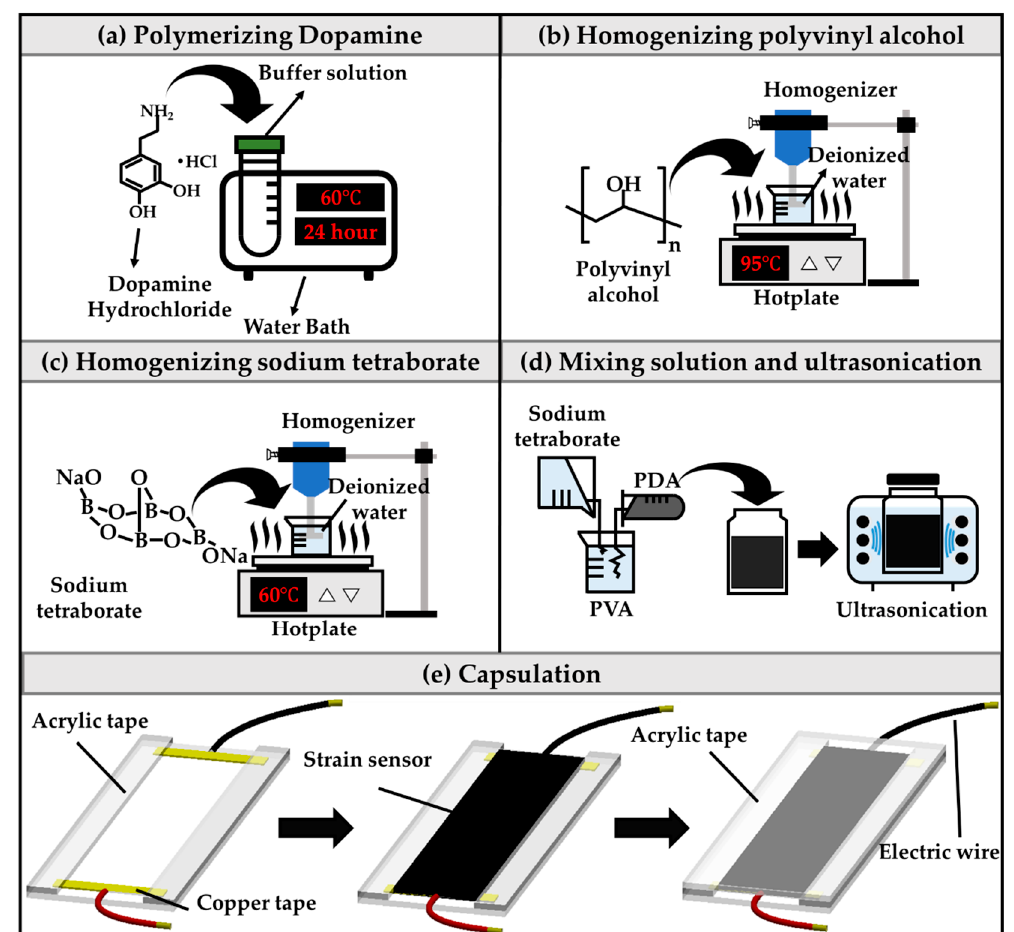
Figure 4. Complete process of sensor fabrication. (a) Dopamine was polymerized in a buffer solution (pH = 8) at 60 °C for 24 h to obtain (PDA). (b) Polyvinyl alcohol (PVA) solution was prepared by mixing PVA powder with deionized water at 95 °C using a homogenizer. (c) Sodium tetraborate powder and deionized water were mixed to form sodium tetraborate solution at 60 °C using the homogenizer. (d) PDA, PVA, and sodium tetraborate solution were mixed in a sealed glass bottle for ultrasonication. (e) Illustration showing the acrylic tape encapsulating the strain sensor.